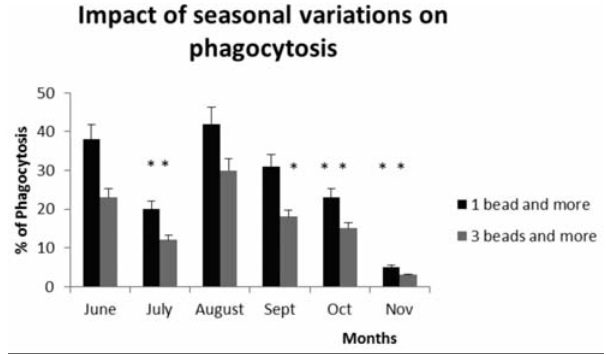
Figure 2. Phagocytic activity of blue mussel, expressed as percent of normal response, shows a higher sensitivity for female than male to mercury with a significant suppression of this function at 10 –5 M for females and 10 –4 M for